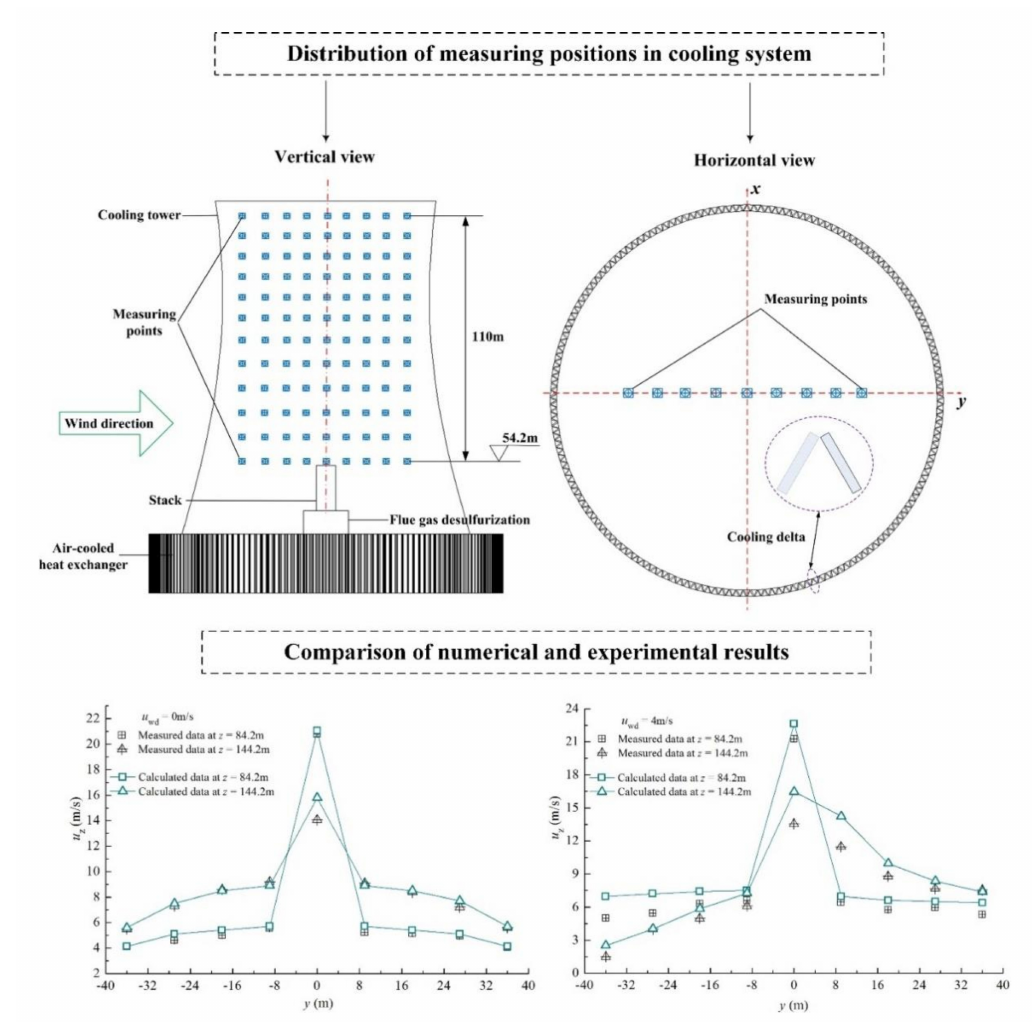
Figure 5. Distribution of the measuring positions in cooling tower and the comparison of the numerical and experimental air flow velocities